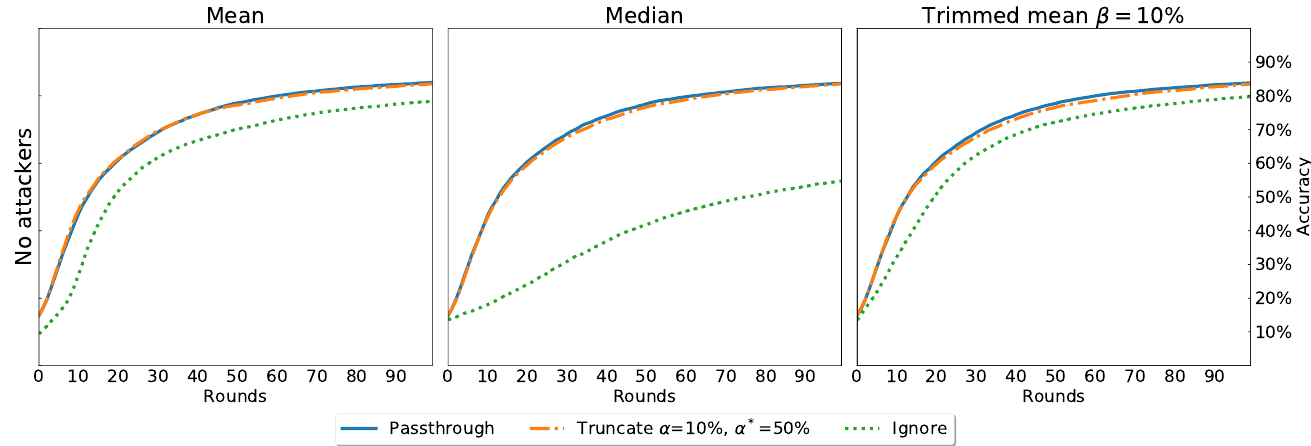
Figure A1. Accuracy by round without any attackers for the MNIST experiments. Curves correspond to preprocessing procedures, and columns correspond to different aggregation